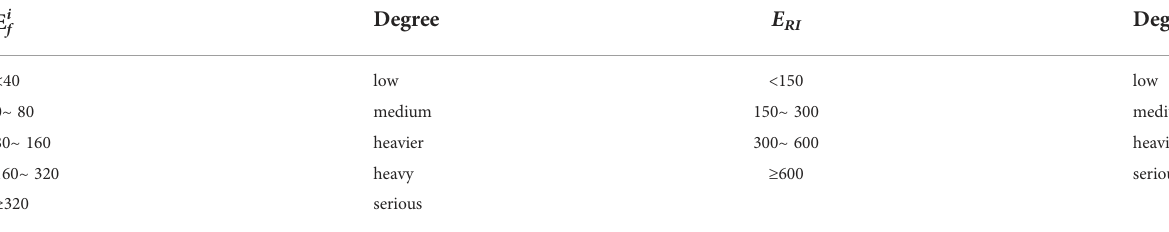
TABLE 2 Potential ecological harm index evaluation criteria. E i